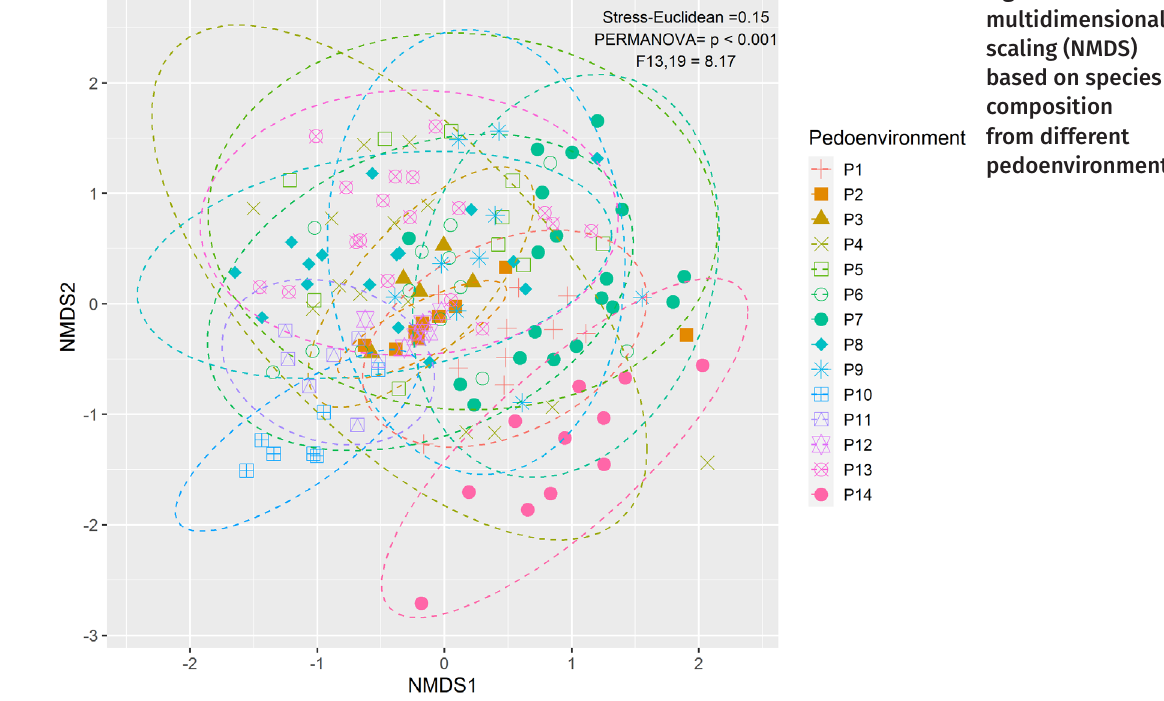
Figure 5. Non metric multidimensional scaling (NMDS) based on species composition from different